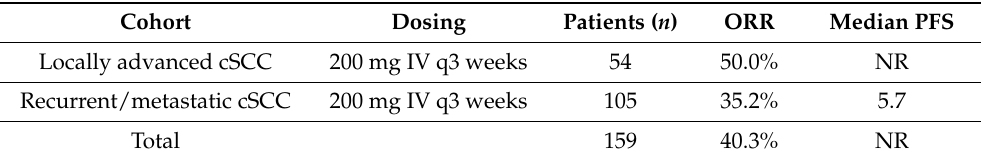
Table 5. Expanded follow-up of phase 2 pembrolizumab data; ORR, objective response rate; PFS, progression free survival (in months); NR, not